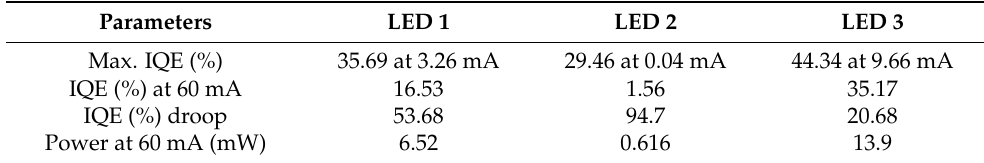
Figure 5. ( a ) Internal quantum efficiency (IQE), ( b ) output power, and ( c ) electroluminescence (EL) intensity of LED 1, LED 2, and LED 3. Table 4. Comparison of internal quantum efficiency (IQE) and output power of LED 1, LED 2, and LED 3.